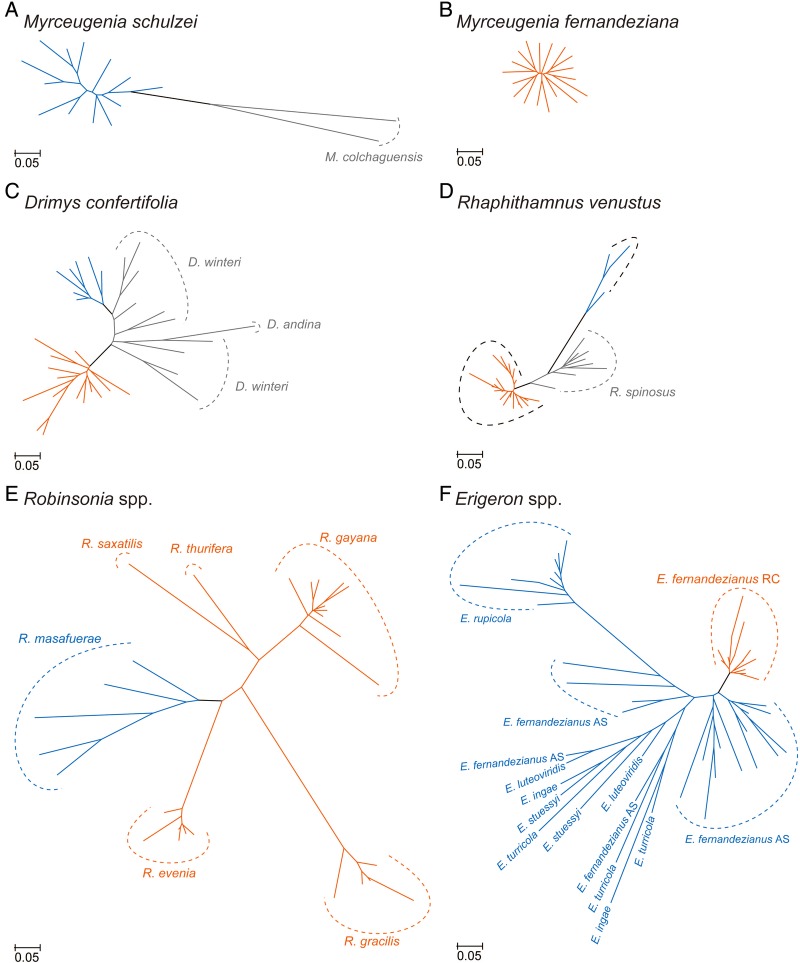
Neighbour-joining tree showing genetic relationships based on SSRs among populations in endemic species of Myrceugenia (A and B), Drimys (C), Rhaphithamnus (D), Robinsonia (E) and Erigeron (F) in the Juan Fernández Archipelago. Closely related continental relatives are also shown in A, C and D. Orange = species and populations on Robinson Crusoe Island; blue = on Alejandro Selkirk Island and black = on the continent.